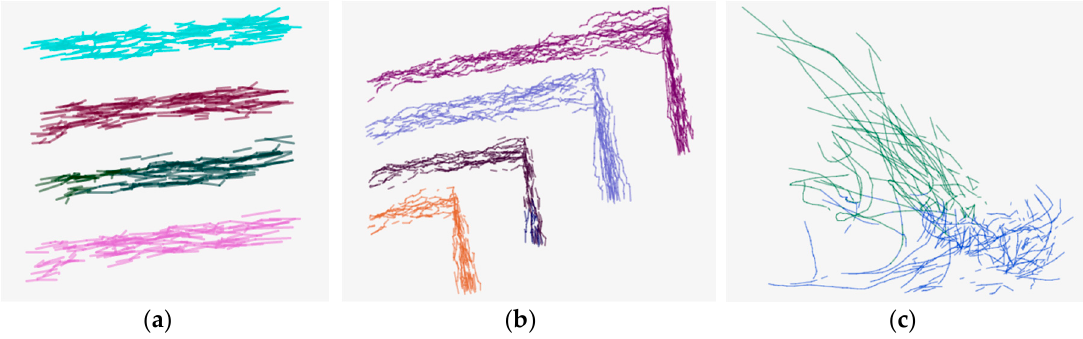
Figure 7. The clustering results on the RT and HT dataset, ( a ) RT1; ( b ) RT2; and ( c ) HT.